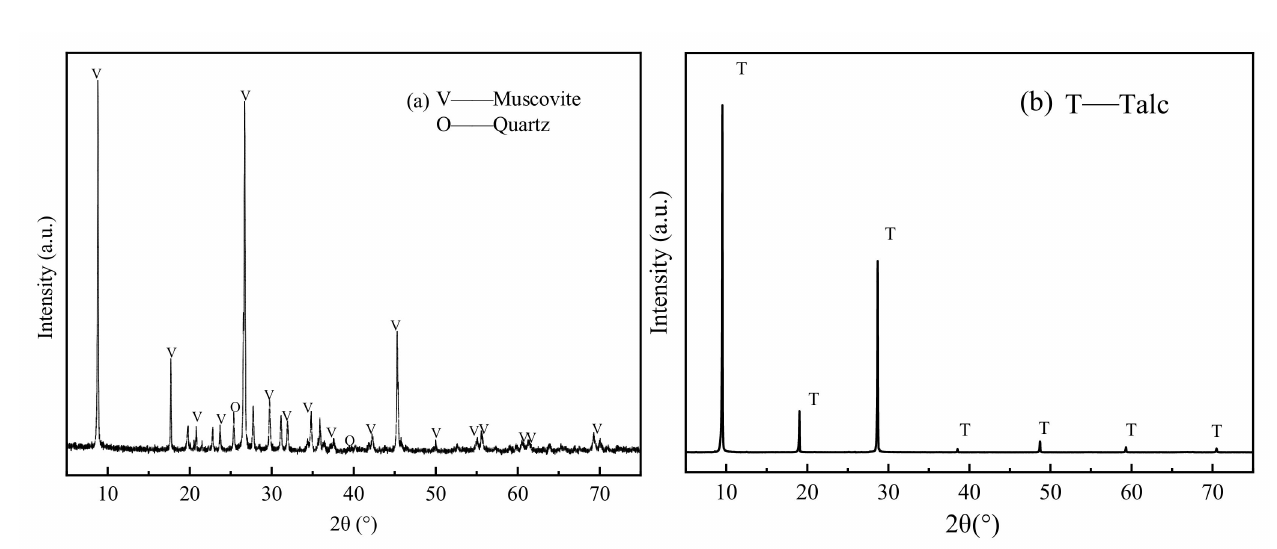
Figure 1. XRD patterns of muscovite and talc samples: ( a ) muscovite; ( b ) talc. Different surfactants including cationic cetyltrimethyl ammoniumchloride